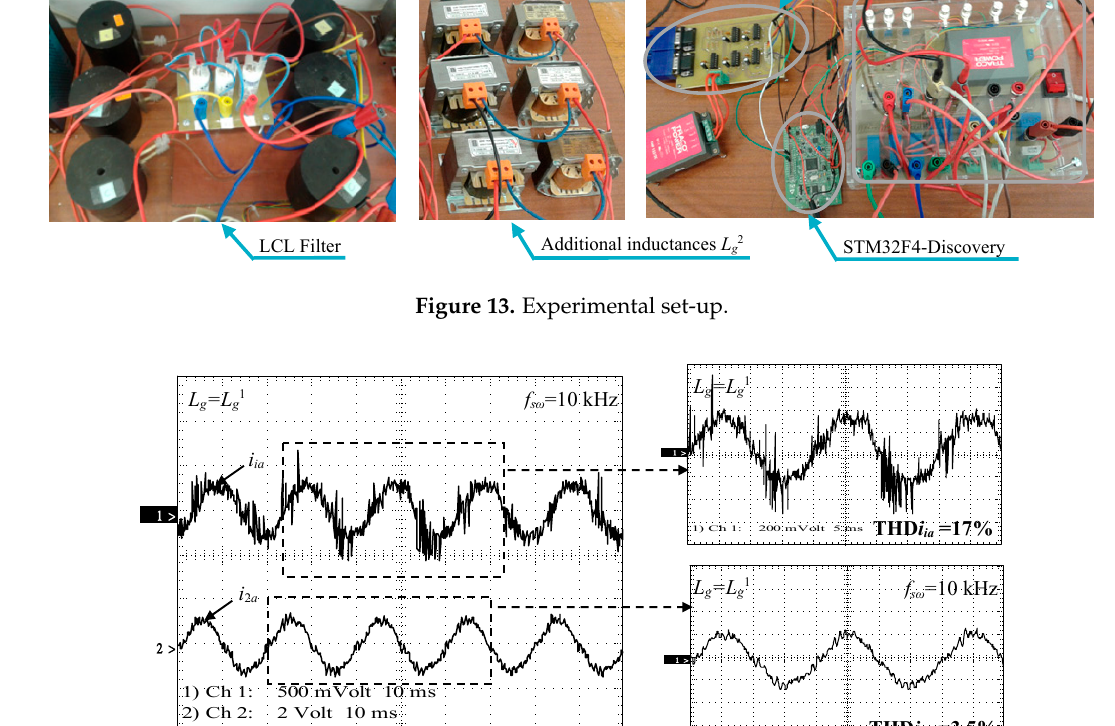
Figure 15. High frequency spectra of ( a ) power converter current ( b) grid current. Figure 16a presents the waveforms of the grid voltage V ga with regard to the grid current i 2 a during steady state operation. The power factor is close to the unity since the grid current and voltage are in phase. Figure 16b shows the waveforms of the converter current i ia and the grid current i 2 a for L g =